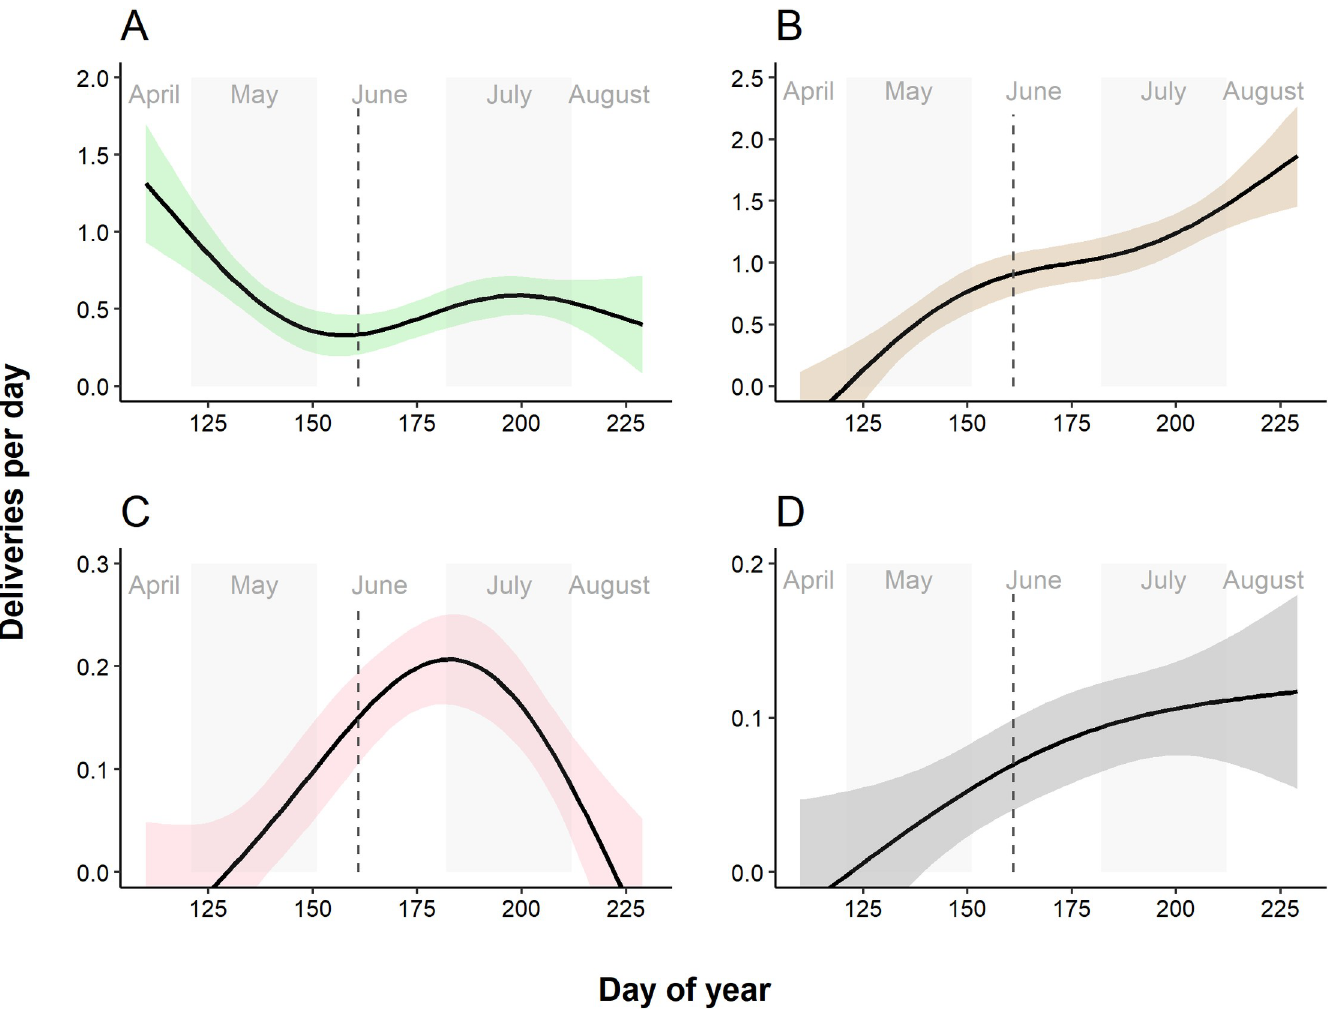
Fig 1. General additive models indicating the relative importance of frogs (A), voles (B), birds (C) and moles (D) in the diet of the Lesser Spotted Eagle. 95% confidence intervals are shaded. Hatching time is indicated by a dashed vertical line. Note the differences in scales on the